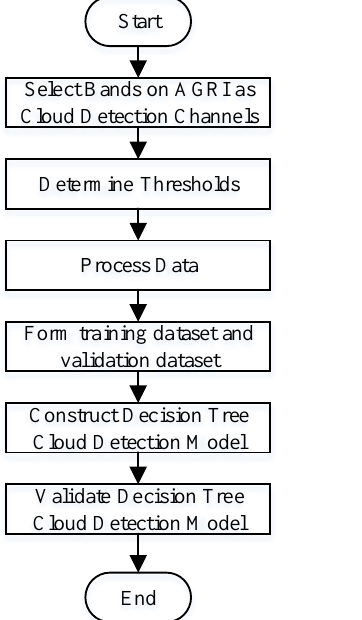
Figure 6. Model cloud test results and true values on training dataset.